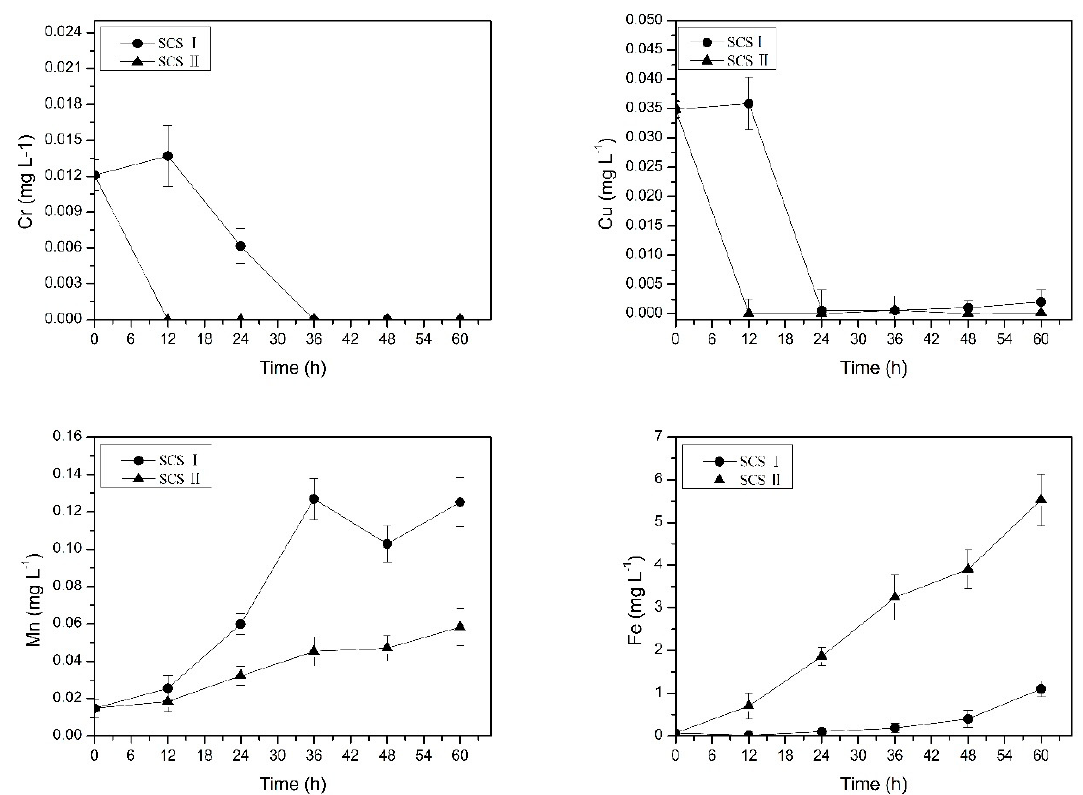
Figure 5. Change in mean concentrations of metal ions in flowing water under two di ff erent simulated corrosion scales conditions. Error bars indicate ± standard deviation.